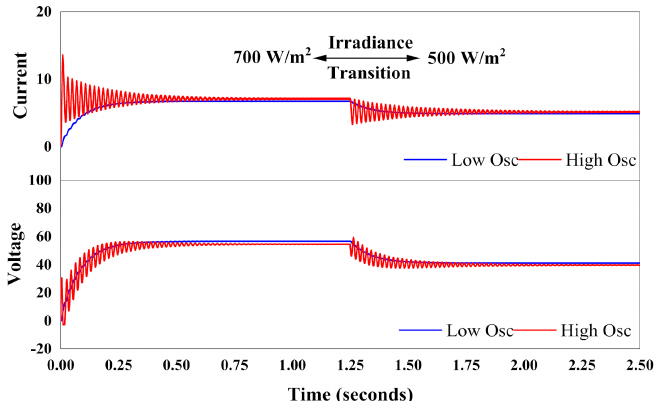
Figure 13. High and low oscillations V-I characteristics during irradiance transition (UI-1 → UI-2).